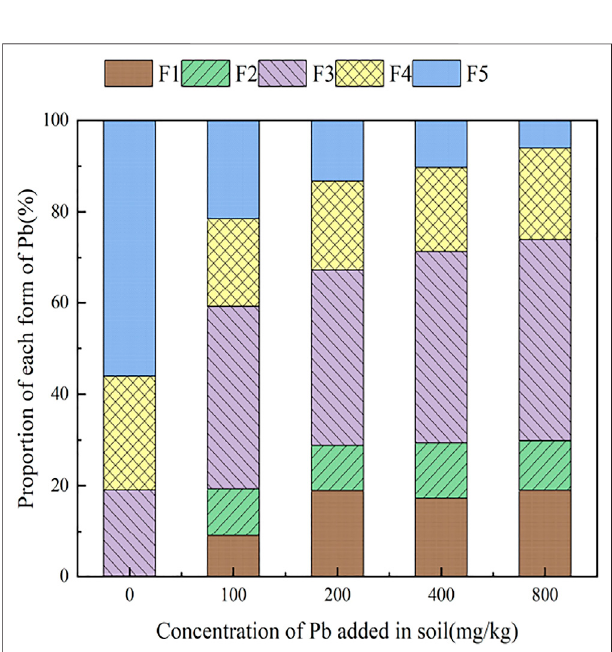
FIGURE 1 | The distribution of Pb form in the soil after adding exogenous